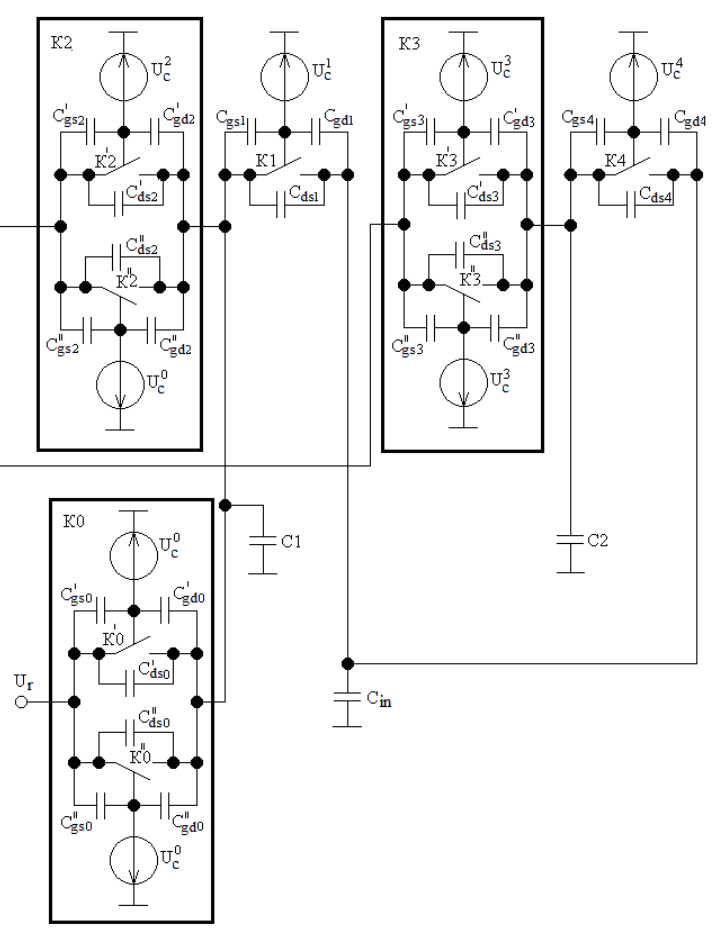
Figure 2. A model of the LADC with successive approximation on SC with a variable logarithm base that takes into account parasitic capacitances.